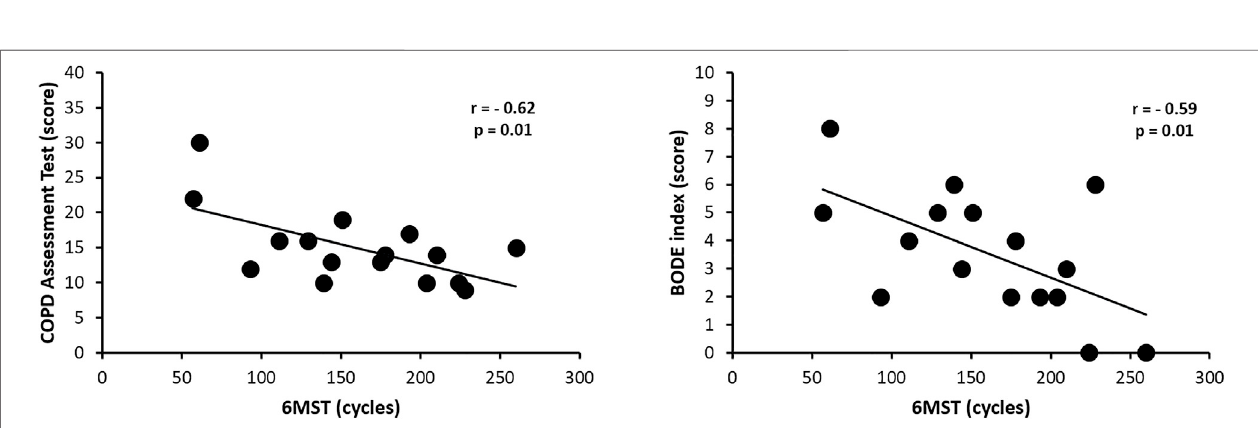
FIGURE 4 | Correlation of 6MST performance with the dynamic hyperin fl ation in absolute values and percentage. Abbreviations: 6MST, 6-min stepper test.